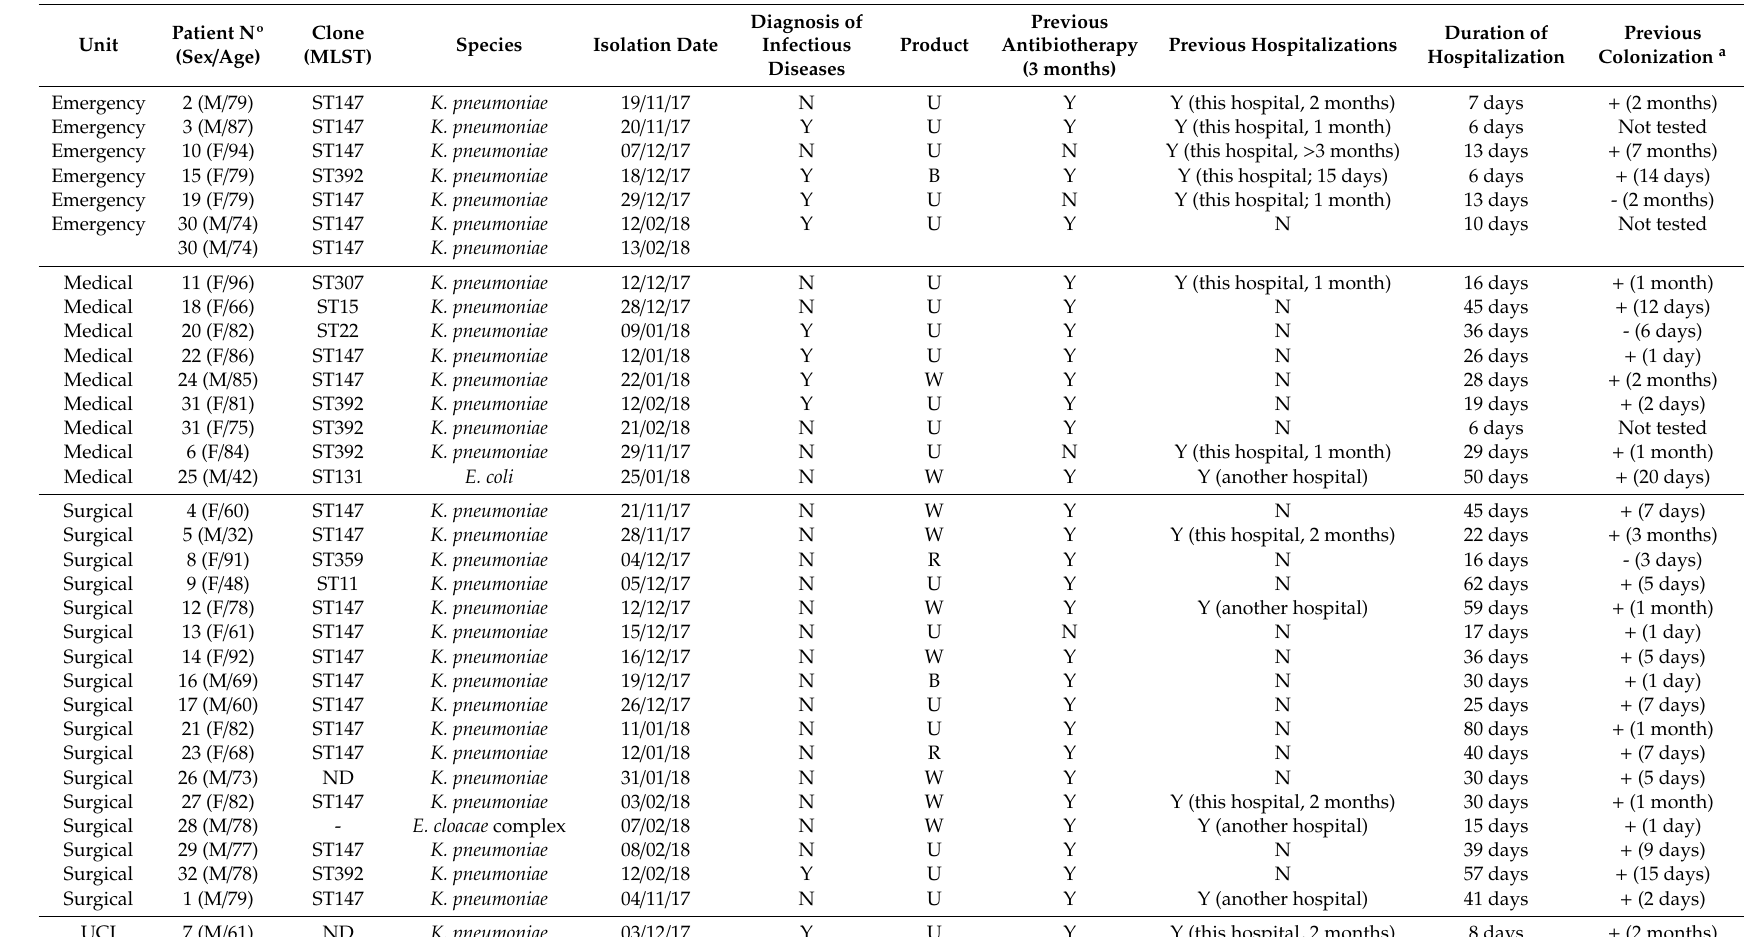
Table 2. Epidemiological data on clinical CPE